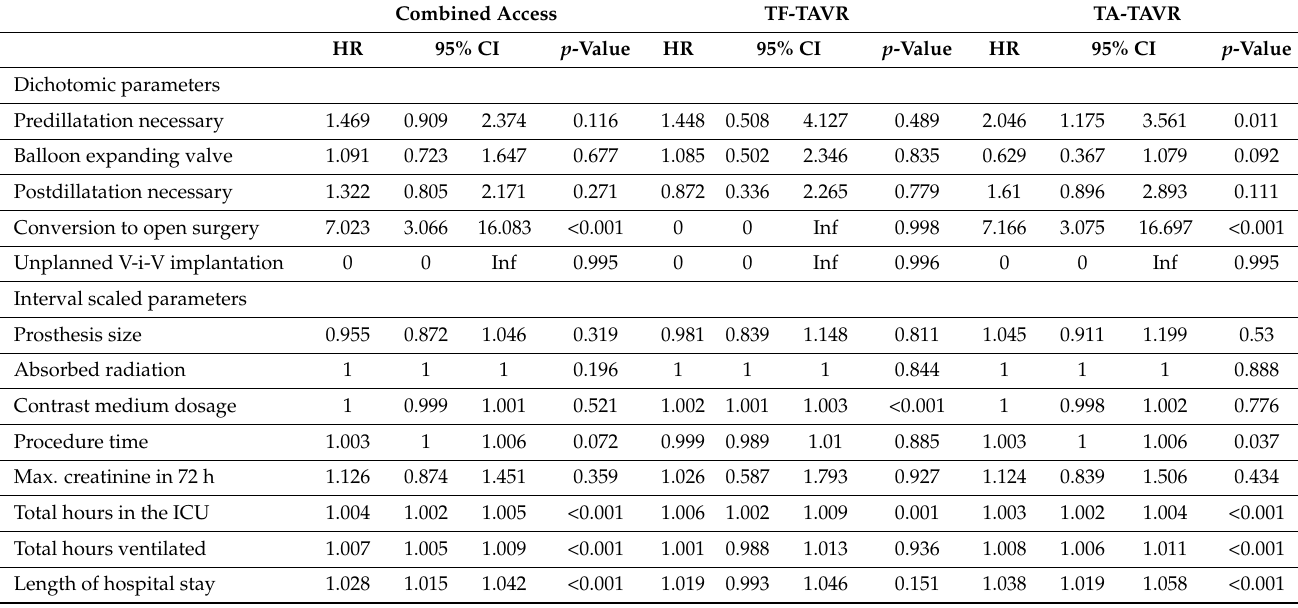
Table 3. Univariate Cox regression analyses of futile events based on interventional parameters. A hazard ratio (HR) above 1 increases the risk, below 1 decreases the risk of